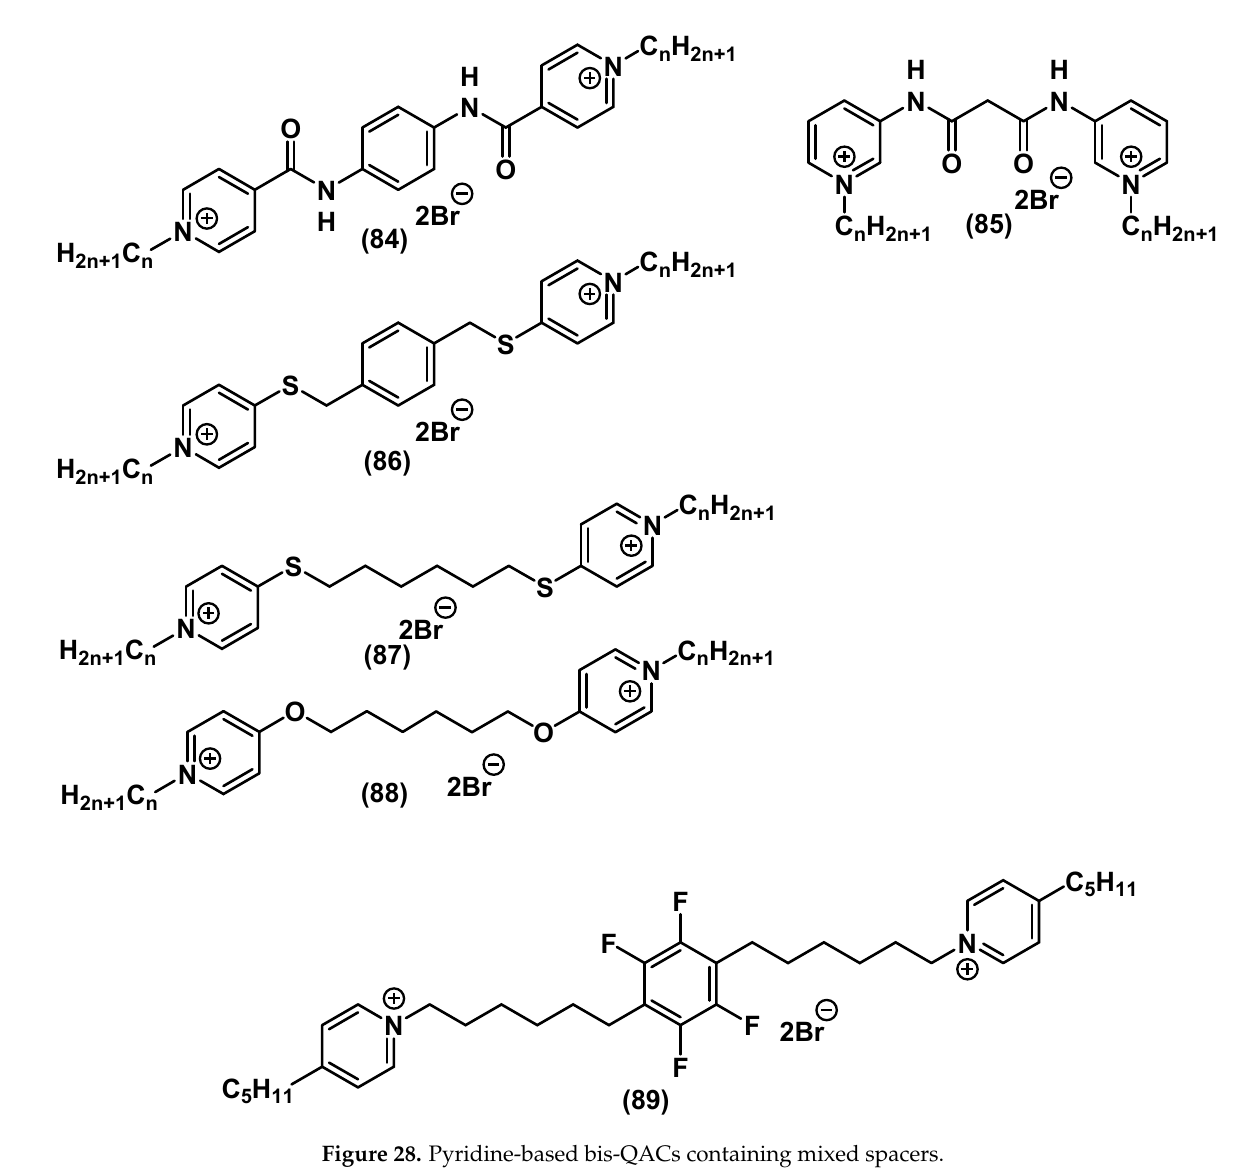
Figure 28. Pyridine-based bis-QACs containing mixed spacers.